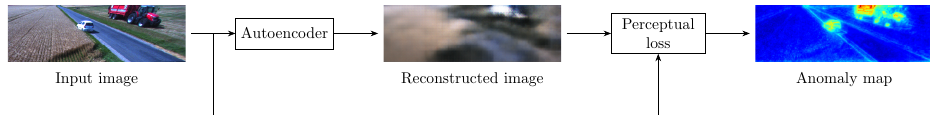
Figure 1. Anomaly detection